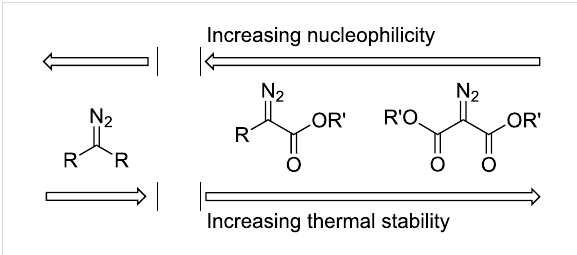
Figure 1: Relative stability and nucleophilicity of non-stabilized (R = H, alkyl) diazo compounds (left) and stabilized (R’ = alkyl, R = H, alkyl) diazo esters